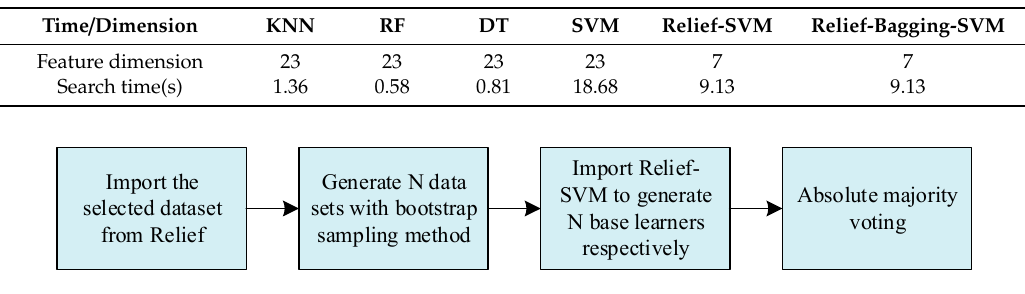
Table 7. Time performance table.